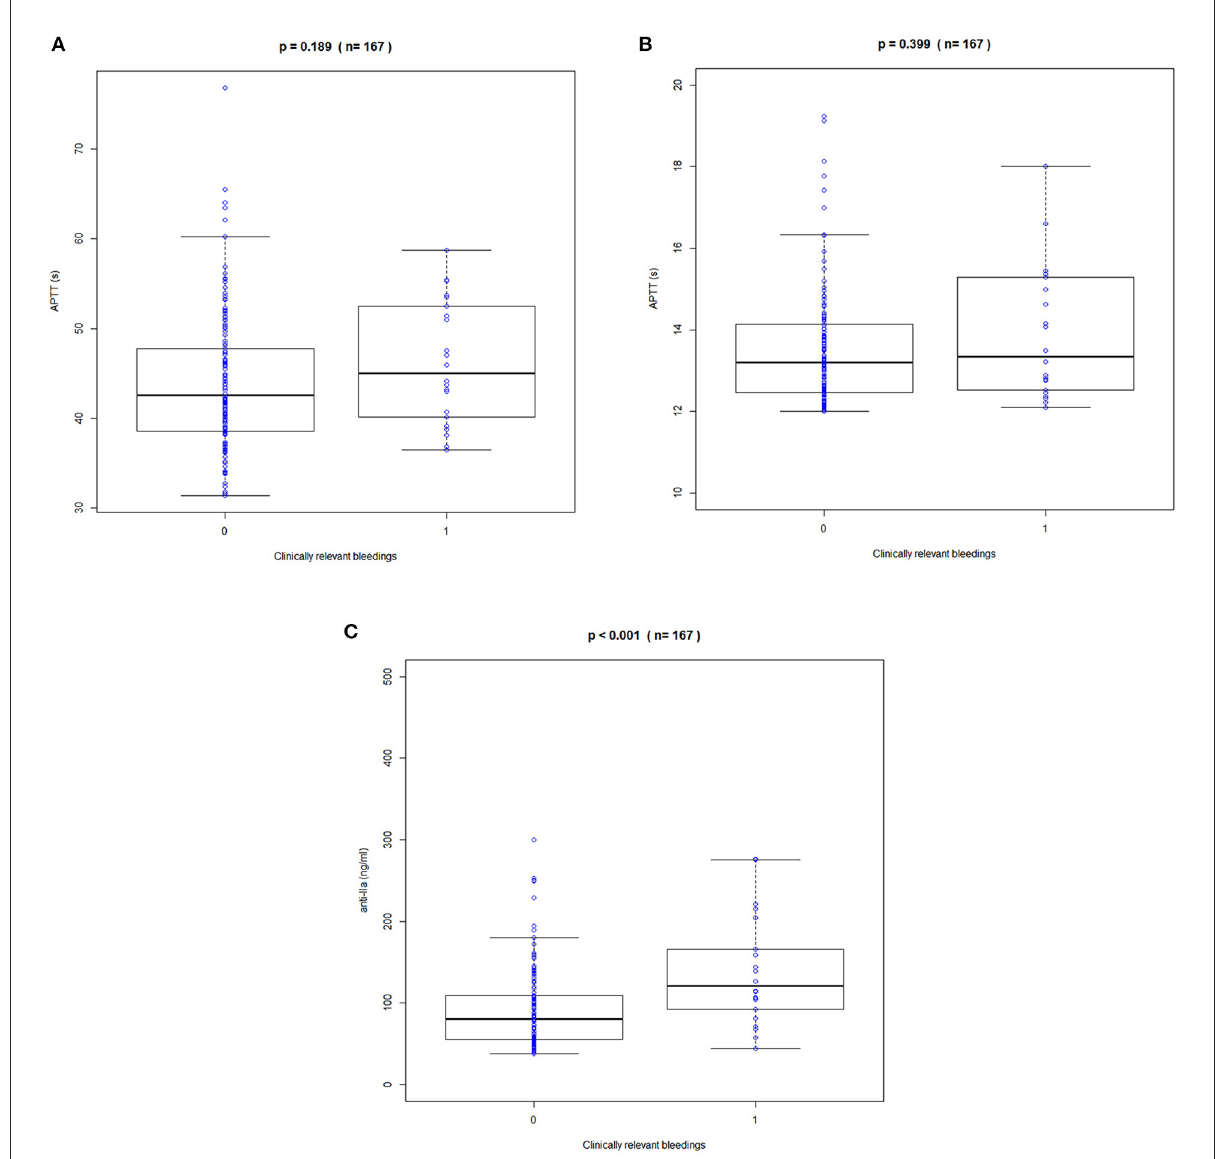
FIGURE4 Correlation between trough APPT, PT, and anti-FIIa values and bleeding events. (A) APTT. (B) PT. (C) Anti-FIIa. Annotation: The blue circle represents the standard dose. Boxes indicate the 25 th -75 th percentiles, whiskers represent 1.5 times the interquartile range, and black horizontal lines represent the median. The blue circles are individual predicted values for the standard dose or